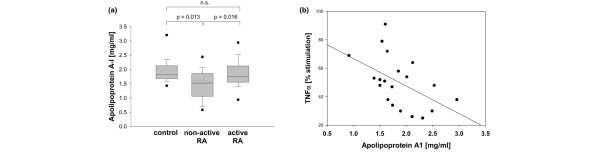
ApoA-1 concentrations are decreased in non-active RA but correlate with the inhibitory serum activity in active RA. (a) Box plot depicting ApoA-1 concentrations in sera from healthy controls (n = 20), in patients with active RA (n = 20) and in patients with non-active disease (n = 20). Levels of significance are given; n.s., not significant. (b) Scatter plot depicting the correlation between ApoA-1 concentrations and inhibitory serum activity in sera from patients with active RA. Each data point represents the ApoA-1 concentration in relation to the inhibitory activity. Tumour necrosis factor (TNF)-α production in the co-culture system containing 10% FCS is set to 100%. The regression line illustrates the negative correlation between the two parameters (correlation coefficient R = -0.527; P = 0.016).